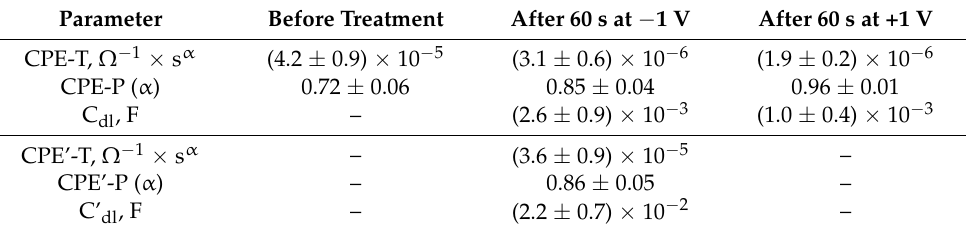
Table 4. EIS data fitting parameters for CPE for the aptasensor before and after cathodic and anodic potentiostatic treatment. Parameter Before Treatment After 60 s at − 1